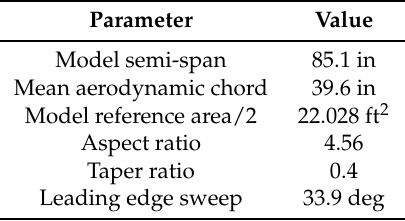
Table 1. Summary of NASA Trap Wing model geometry [19].